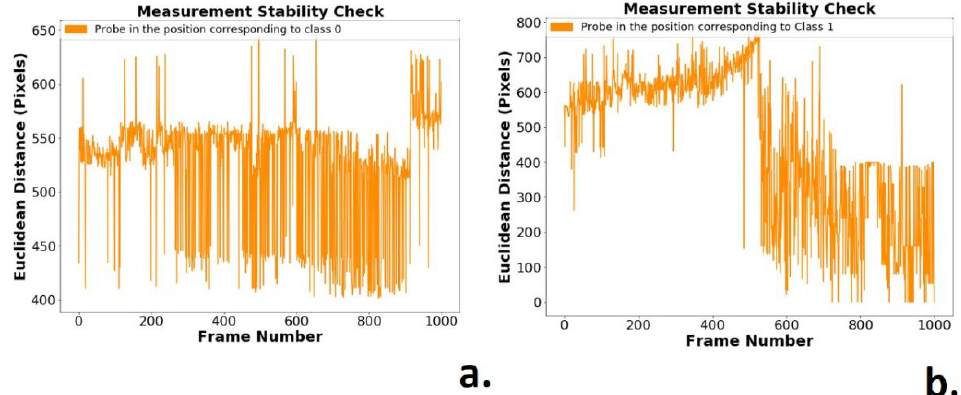
Figure 13. Euclidian distance between the red and blue markers: ( a ) Probe in static operation, class 0; ( b ) Probe in lifting operation, class 1.